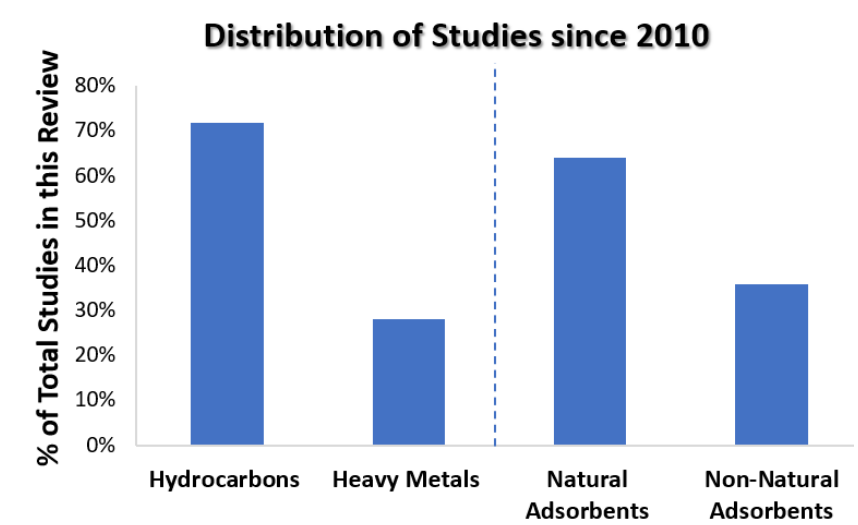
Figure 3. Distribution of recent adsorption studies, since 2010. The left hand side shows the portion of adsorbent studies that targeted hydrocarbons or heavy metals, where the right hand side is the portion of studies that utilized natural or non-natural